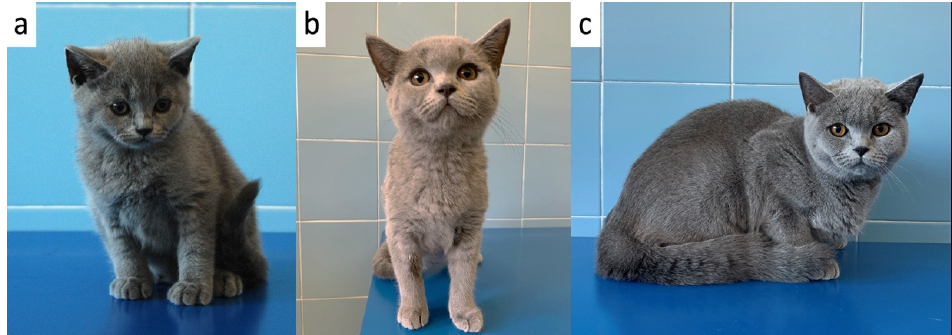
Figure 5. One of the 3 kittens (kitten F1) at 83 ( a ), 185 ( b ) and 365 days of age ( c ).